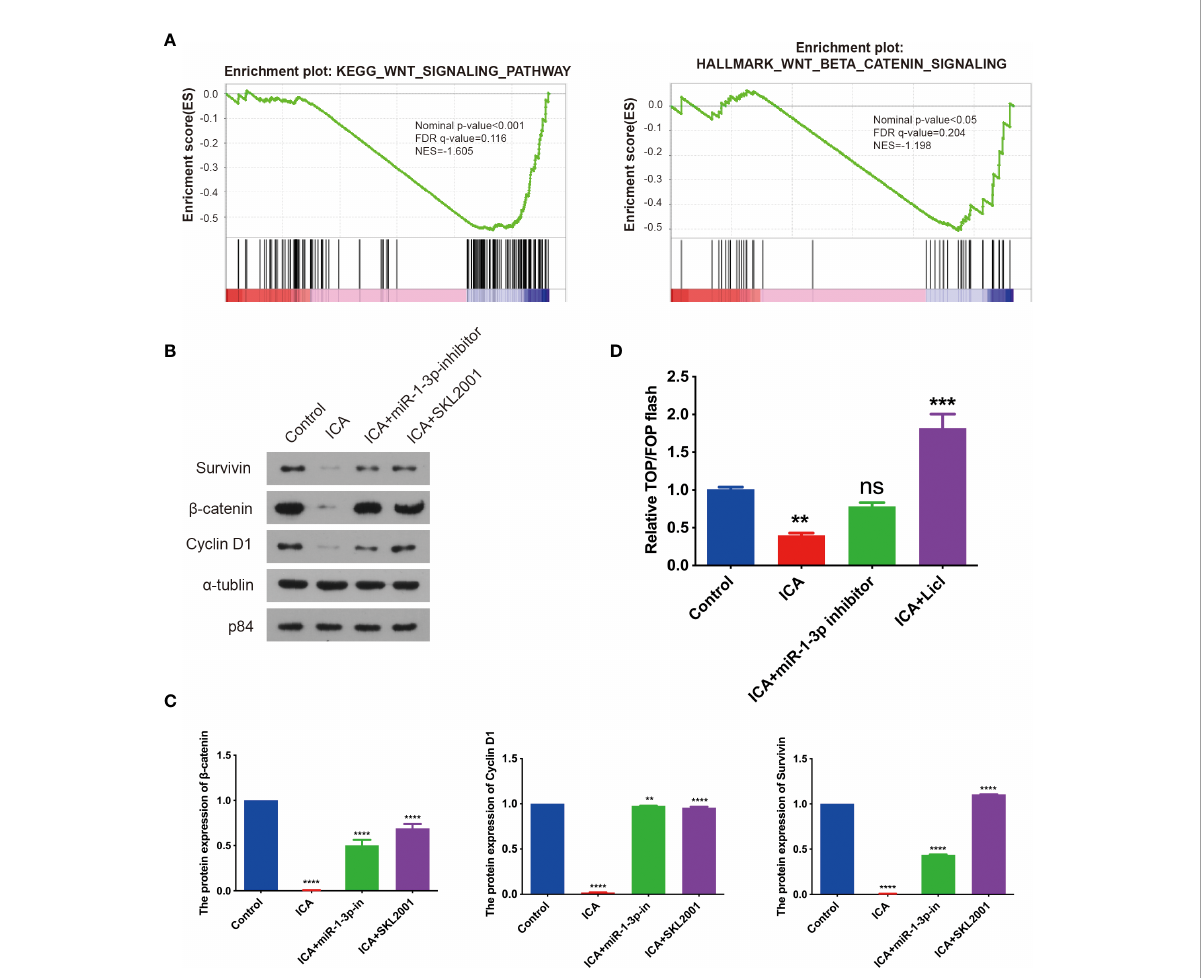
FIGURE 3 Icariin suppress Wnt/ b -catenin signaling through upregulating miR-1-3p. (A) GSEA for the expressions of miRNAs in SKOV-3 cells treated with 50 m M icariin, revealing the action of icariin for the downregulated Wnt/ b -catenin signaling pathway gene signatures. (B, C) The cells grew overnight in a 6-well plate, SKOV-3 cells were incubated with or without icariin (50 m M) combined with miR-1-3p inhibitor transfection or SKL2001 (50 m M) for 48h. The expression of b -catenin, Cyclin D1, and Survivin were analyzed with western blotting. The diagram represents three separate experiments. Three independent western blotting assays were statistically analyzed. (D) TOP/FOP fl ash reporter assay in 293T cells treated with 50 m M icariin combined with miR-1-3p inhibitor transfection or LiCI for 48h before luciferase measurement. Statistical analysis of the result from three independent assays. Data were shown with the mean±SD, ns P > 0.05, **p<0.01, ***p<0.001,